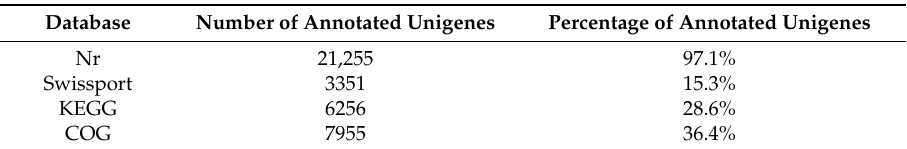
Table 2. Annotation of non-redundant unigenes.